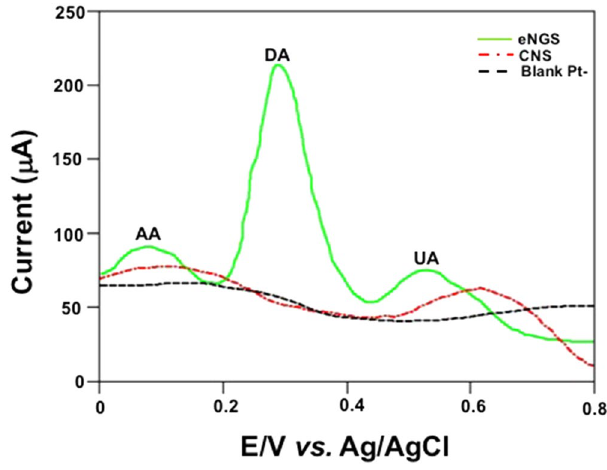
Figure 6. Bare Pt-, Pt-/CNS, and Pt-/eNGS in 100 µ M DA (in 0.1 M PBS/pH 7.4) in the presence of interferences (150 µ M AA and UA) at 50